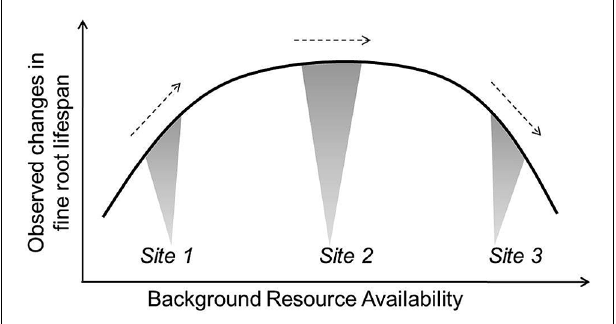
FIGURE 5 | Conceptual example of how equivalent additions of the same resource (e.g., irrigation or N fertilization) could result in observed increases, decreases, and no change in fine root lifespan depending on background resource availability or other site characteristics. Site 2 represents average background resource availability and soil conditions. Site 1 is low in resource availability and would see an increase in root lifespan with an increase in a given resource while lifespan decreases in Site 3 where resource availability has exceeded plant demand and the buffering capacity of soils (e.g., anoxia or decreasing soil